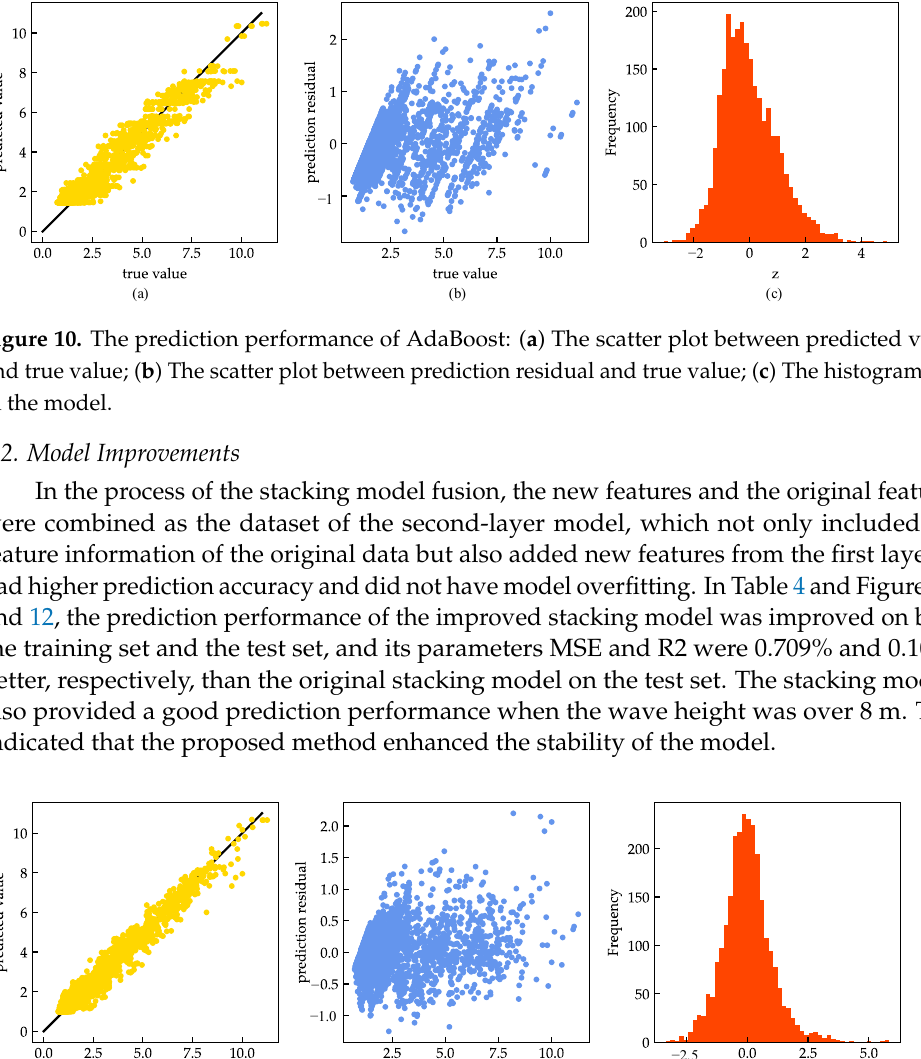
Figure 9. The prediction performance of RF: ( a ) The scatter plot between predicted value and true value; ( b ) The scatter plot between prediction residual and true value; ( c ) The histogram of z in the model.